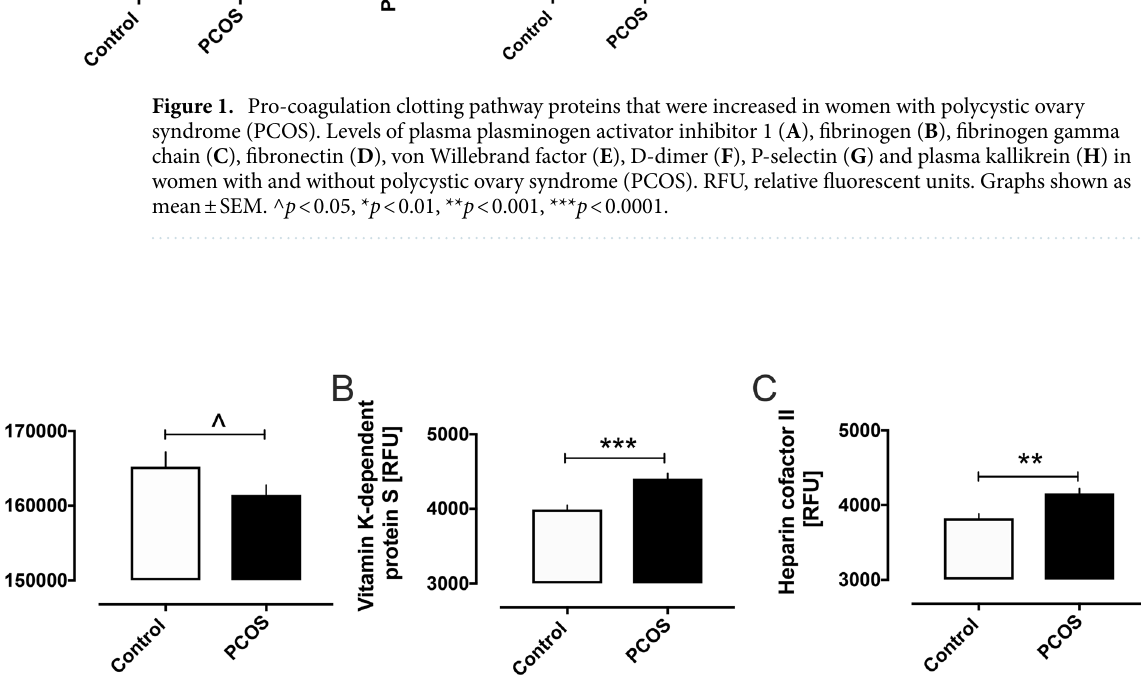
Figure 2. Anti-coagulation clotting pathway proteins that were altered in women with polycystic ovary syndrome (PCOS). Levels of plasma prothrombin ( A ), Vitamin K dependent Protein S ( B ) and heparin cofactor II in women with and without polycystic ovary syndrome (PCOS). RFU, relative fluorescent units. Graphs shown as mean ± SEM. ^ p < 0.05, ** p < 0.001, *** p <